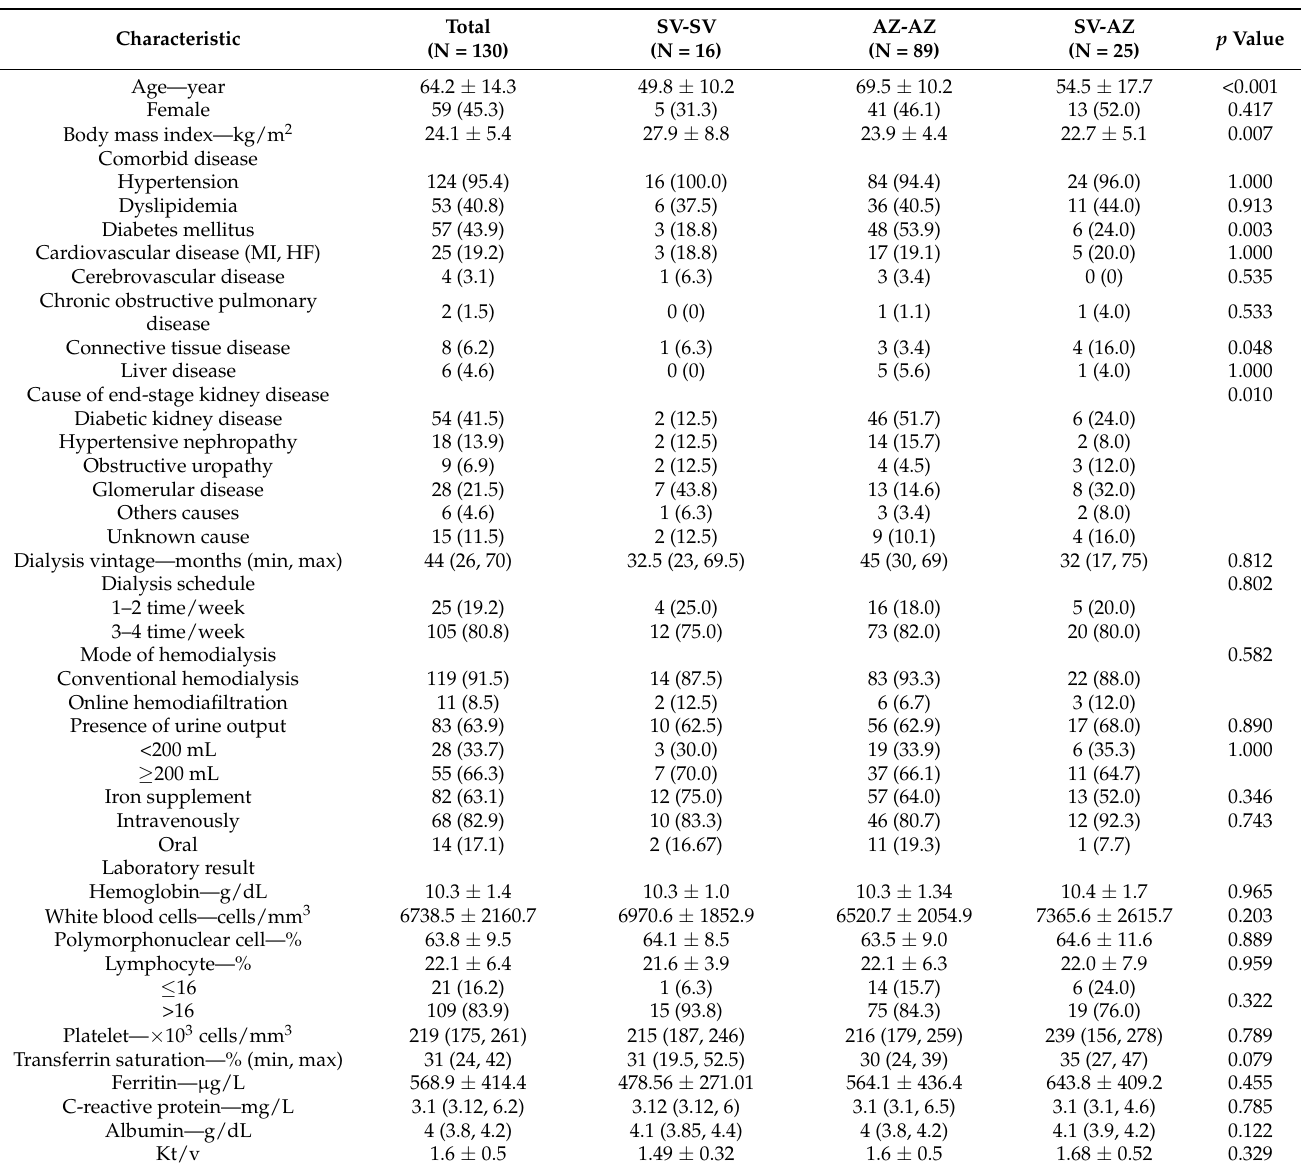
Table 1. Baseline clinical characteristics and laboratory results of participants according to the vaccine